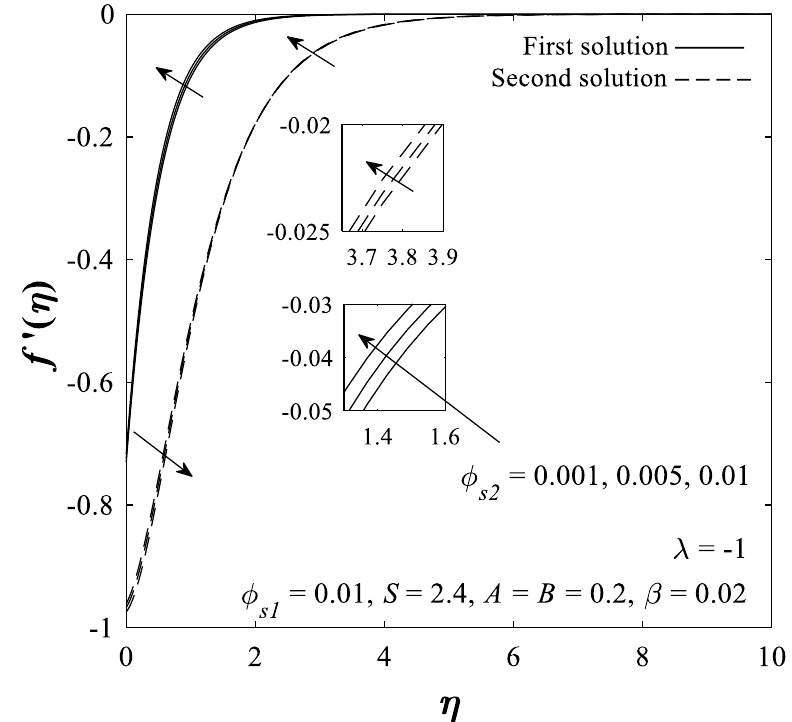
Figure 14. Velocity profile f (cid:48) ( η ) for varied φ s 2